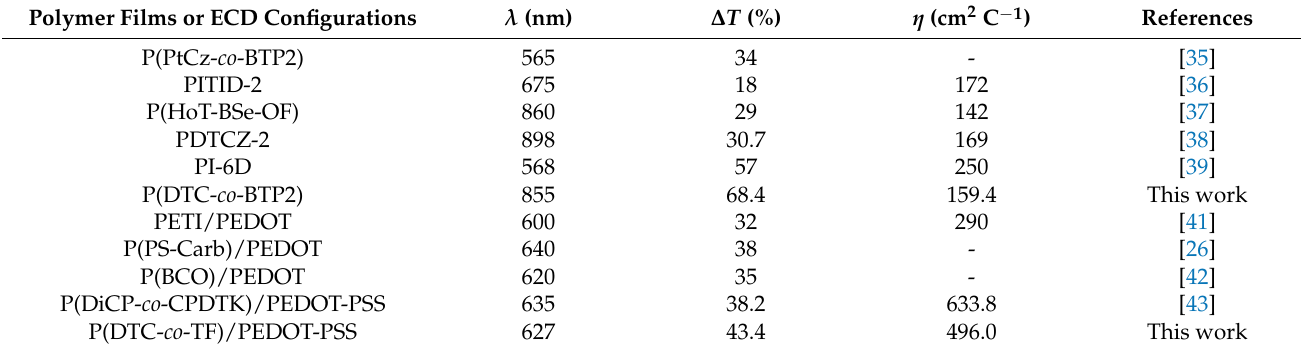
Table 4. Transmittance changes and coloration efficiencies of polymer films and